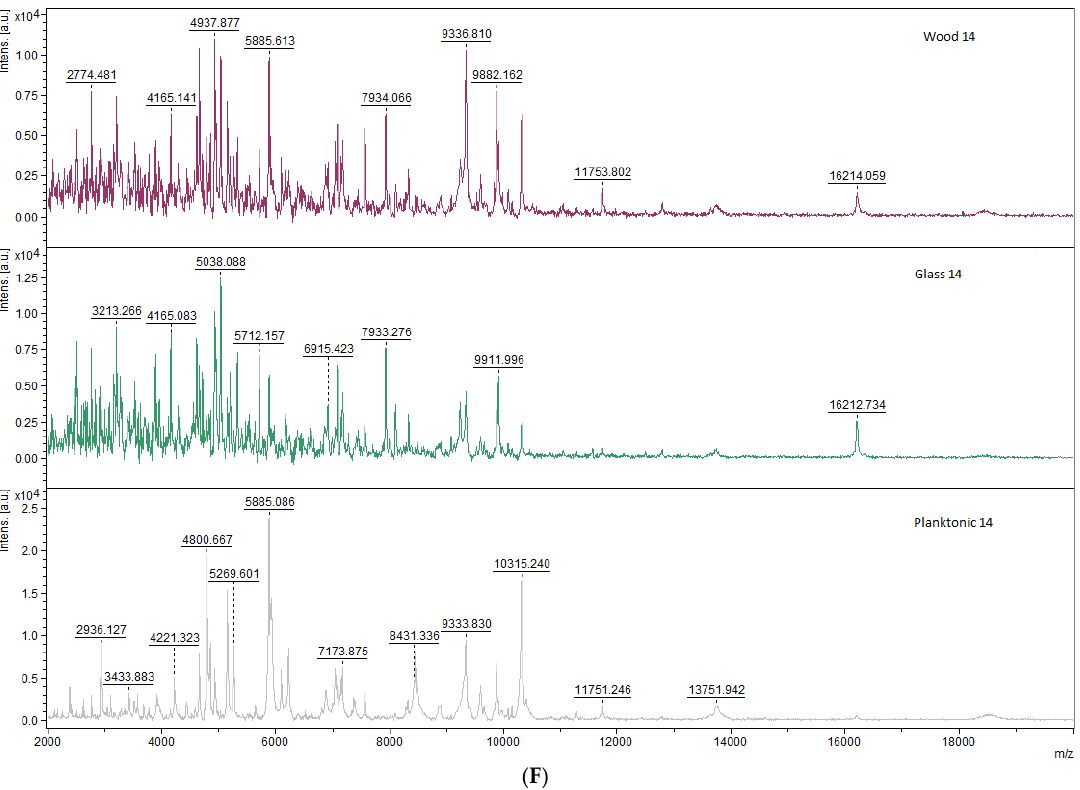
Figure 2. Representative MALDI-TOF mass spectra of B. subtilis : ( A ) 3 day; ( B ) 5 day; ( C ) 7 day; ( D ) 9 day; ( E ) 12 day; ( F ) 14 day.